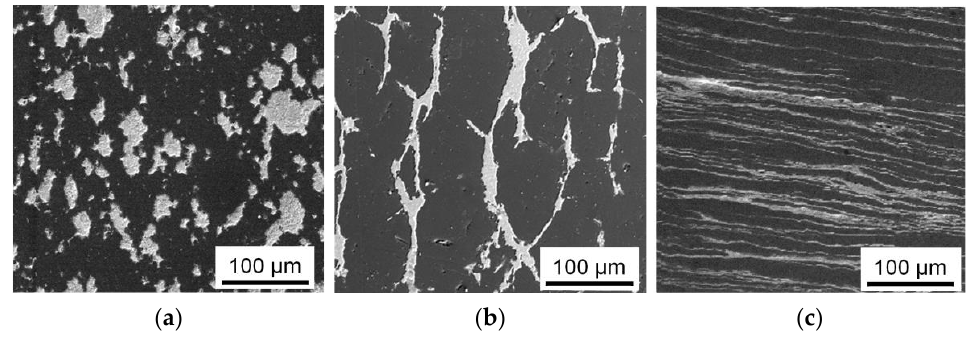
Figure 2. SEM (SE) images of the structure of green ( a ), sintered ( b ), and subjected to four ECAP-A passes ( c ) Al-30Sn alloy.